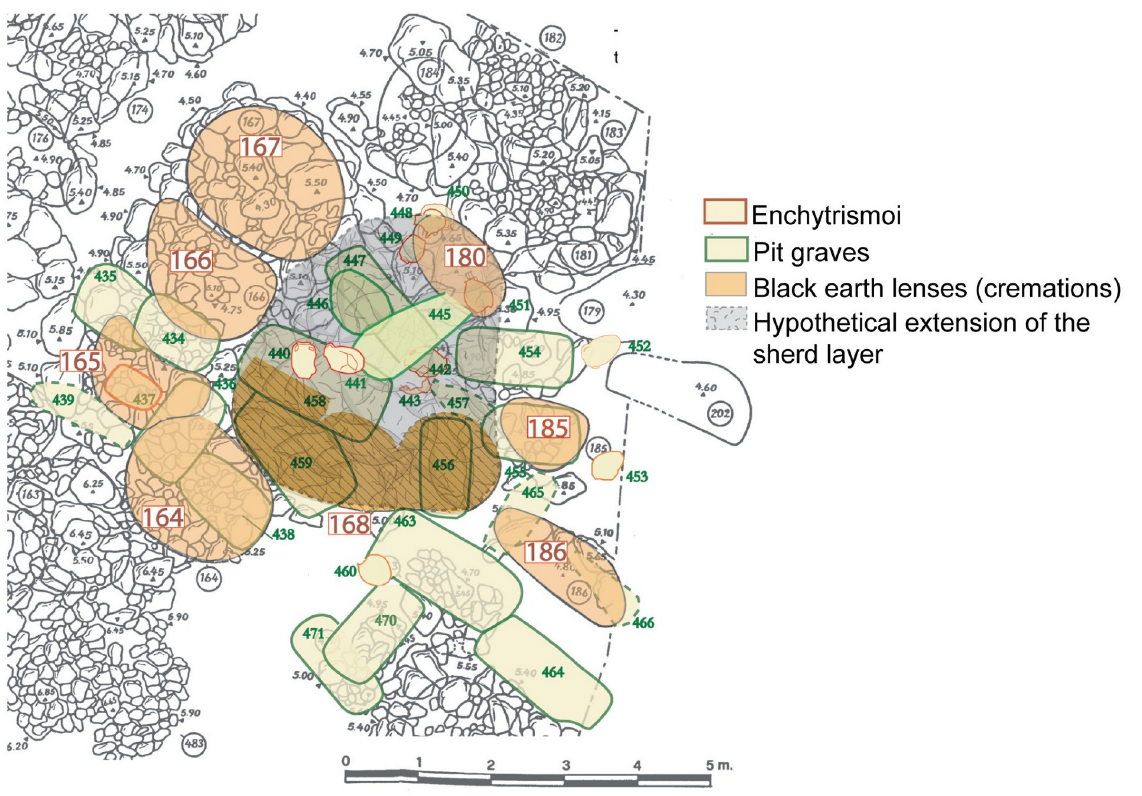
Fig 4. The Tomb of Nestor’s Cup (Cremation 168) and the cremation tumuli near it (elaborated from [2], plan AII and AII bis by T.E. Cinquantaquattro). The cluster of Cremation 168 and Tumuli 164, 165, 166, 167, 180, 185, 186 (from left to right). In dark yellow, the ’ black earth lenses ’ and the three depressions of Cremation 168. In grey, the ’ sherd layer ’ of Cremation 168.